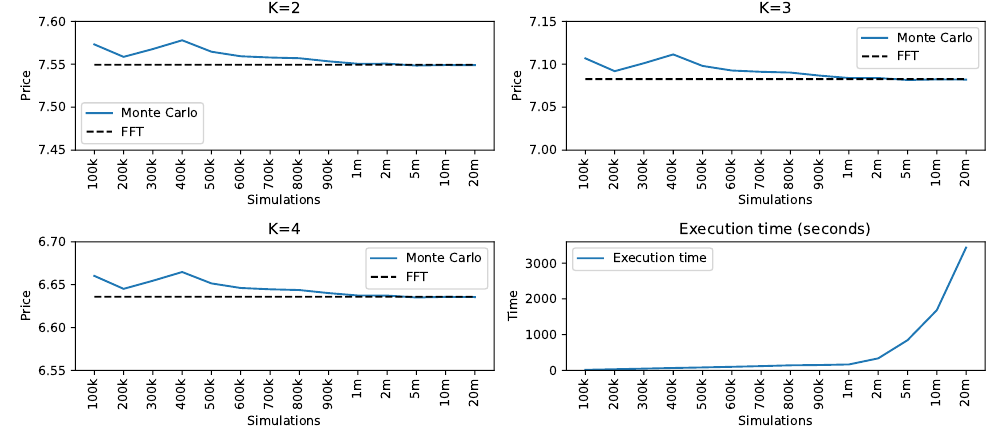
Figure 1. Monte Carlo convergence using the parameters in Table 1.